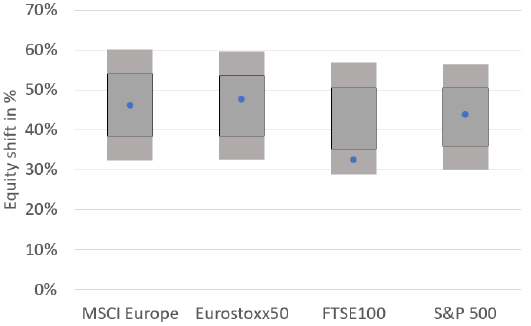
Figure 8. Comparison of the simulated shifts for equity risk factors, and representation based on own results (blue dots) and EIOPA (2021a, p. 27) (gray boxes).